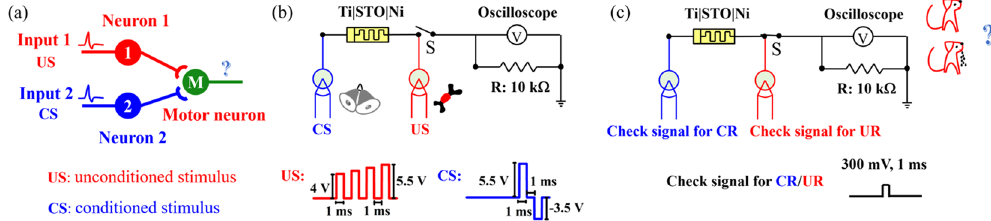
Figure 2. Pavlovian conditioning circuit design. ( a ) Prototype of the Pavlovian conditioning. After US reaches neuron 1, the neighbouring motor neuron responds to it; while in the case of CS, whether the motor neuron close to neuron 2 responds depends on the interconnection strength between them. ( b ) Memristive circuit with electrical US and CS to mimic the Pavlovian conditioning. CS is applied on the Ti electrode, while US is applied on the Ni electrode, and the oscilloscope is used to test the divided voltage of the resistor (10 kΩ), which reflects the response of the motor neuron. ( c ) Circuit with switch ( S ) in ON state to check whether CR/UR is